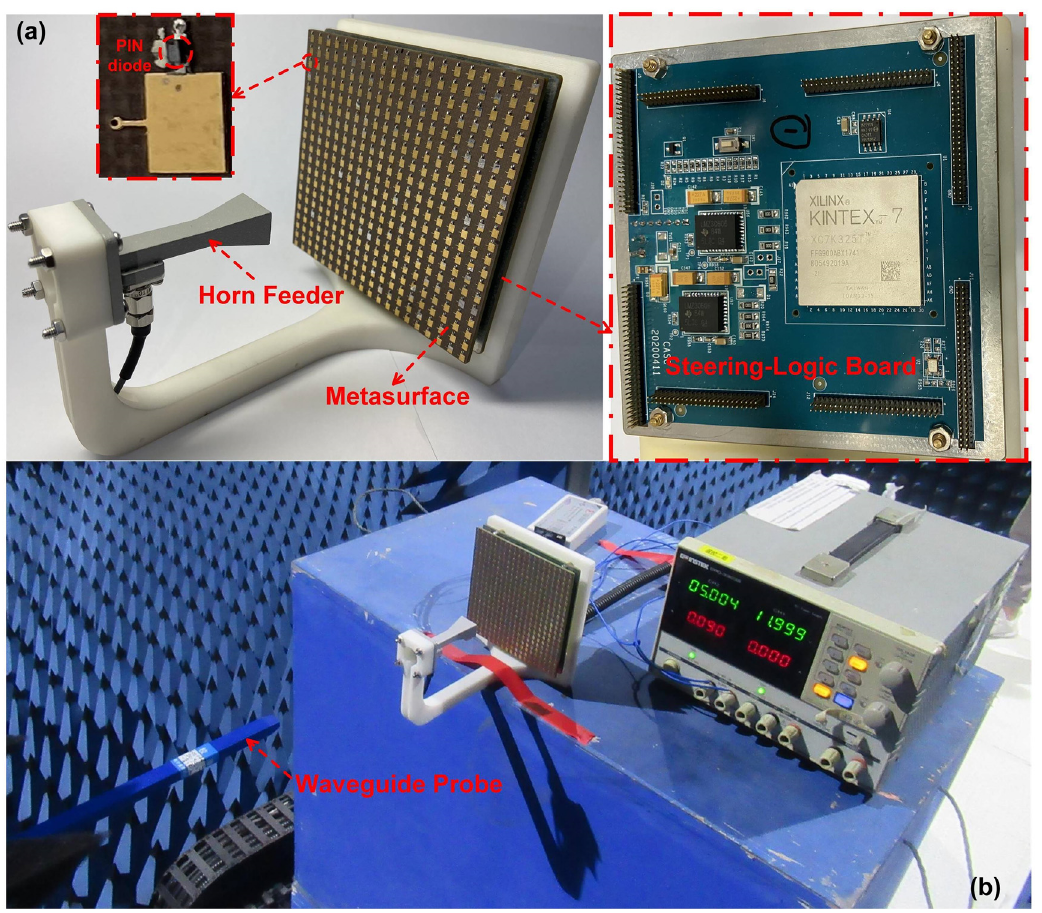
Figure 6: Fabricated prototype of the mmWave programmable metasurface. (a) Metasurface along with the horn feeder as well as the steering-logic board. (b) Experimental setup with a waveguide probe in near field